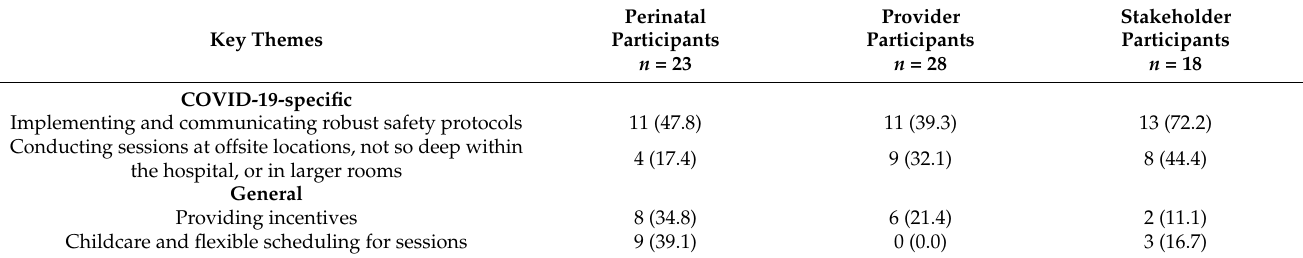
Table 3. Reported facilitators to resuming in-person psychotherapy sessions, n